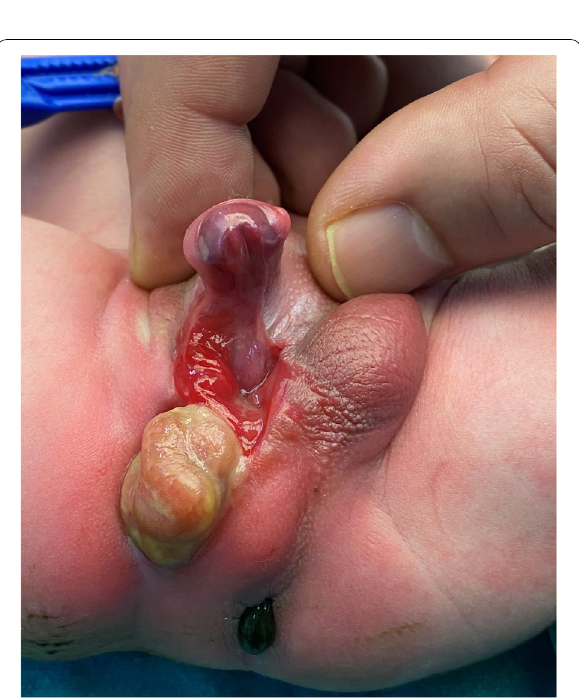
Fig. 3 Extreme perineal hypospadias, with a patch of mucosa with central pit seen around the urinary meatus raising the possibility of vaginal